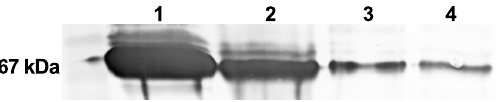
Figure 4. Orientation of MBP-apocytochrome b 6 in proteolipo- somes reconstituted with dodecyl maltoside removed with Bio-Beads was analyzed by Western blotting with anti-MBP antibodies. Purified, concentrated MBP-apocytochrome b 6 in DM solution (1); DM solution of MBP-apocytochrome b 6 added for reconstitution (2); untreated proteoliposomes (3); proteoliposomes treated with proteinase K (4). Lanes 3 and 4 contain the same amount of proteoliposomes.